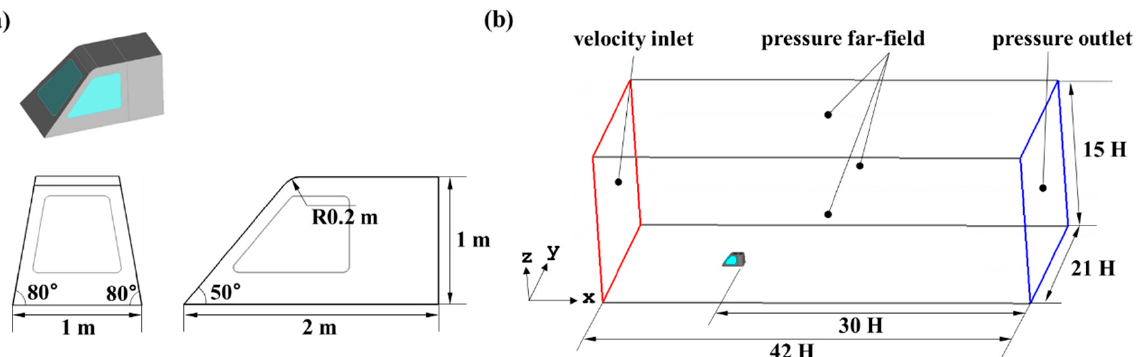
Figure 3. Target model of Hyundai Simplified Model (HSM) and entire computational domain: ( a ) overall shape of HSM with related geometric dimensions; ( b ) dimensions of computational domain with boundary conditions applied, where H denotes the height of the HSM. Table 2. Details on applied boundary conditions.